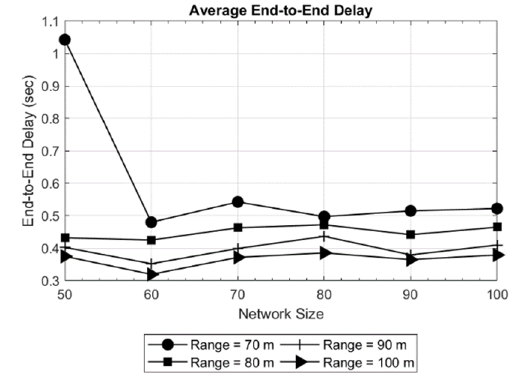
Figure 5. Average delay in network of 200 × 200 × 200